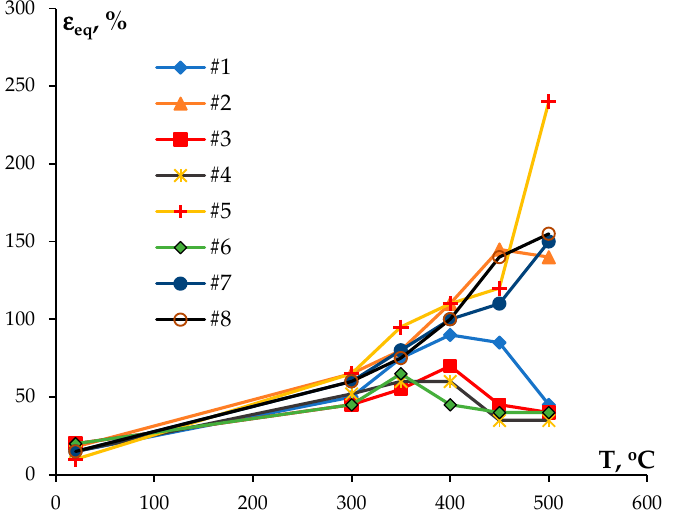
Figure 6. Dependence of homogeneous (uniform) strain on test temperatures in UFG alloys.